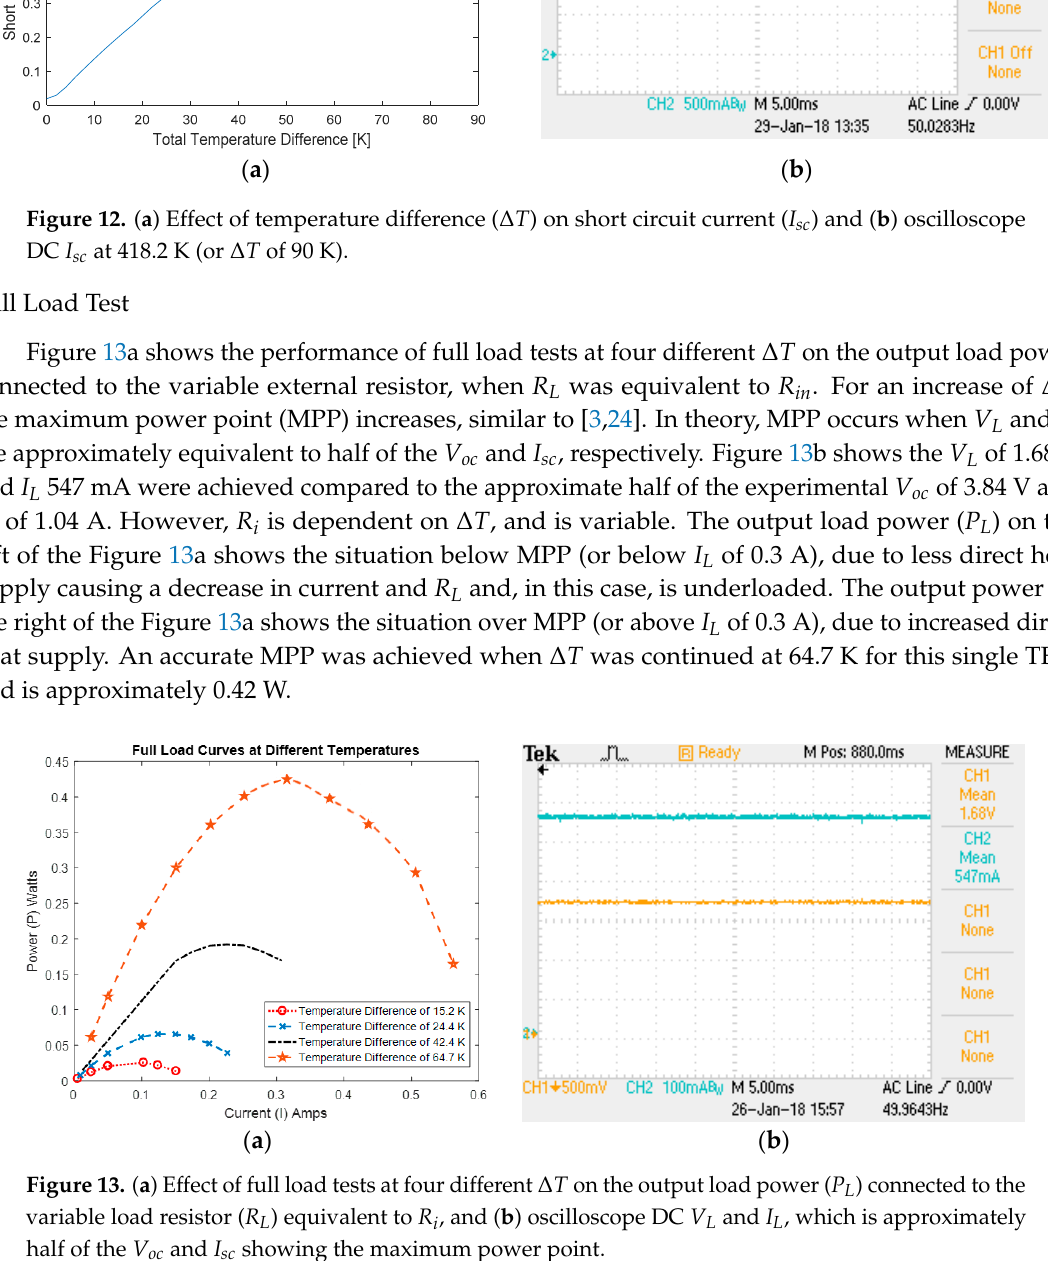
Figure 12. ( a ) Effect of temperature difference ( Δ𝑇 ) on short circuit current ( I sc ) and ( b ) oscilloscope DC I sc at 418.2 K (or Δ𝑇 of 90 K).